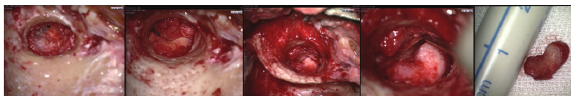
Figure 3: Intraoperative